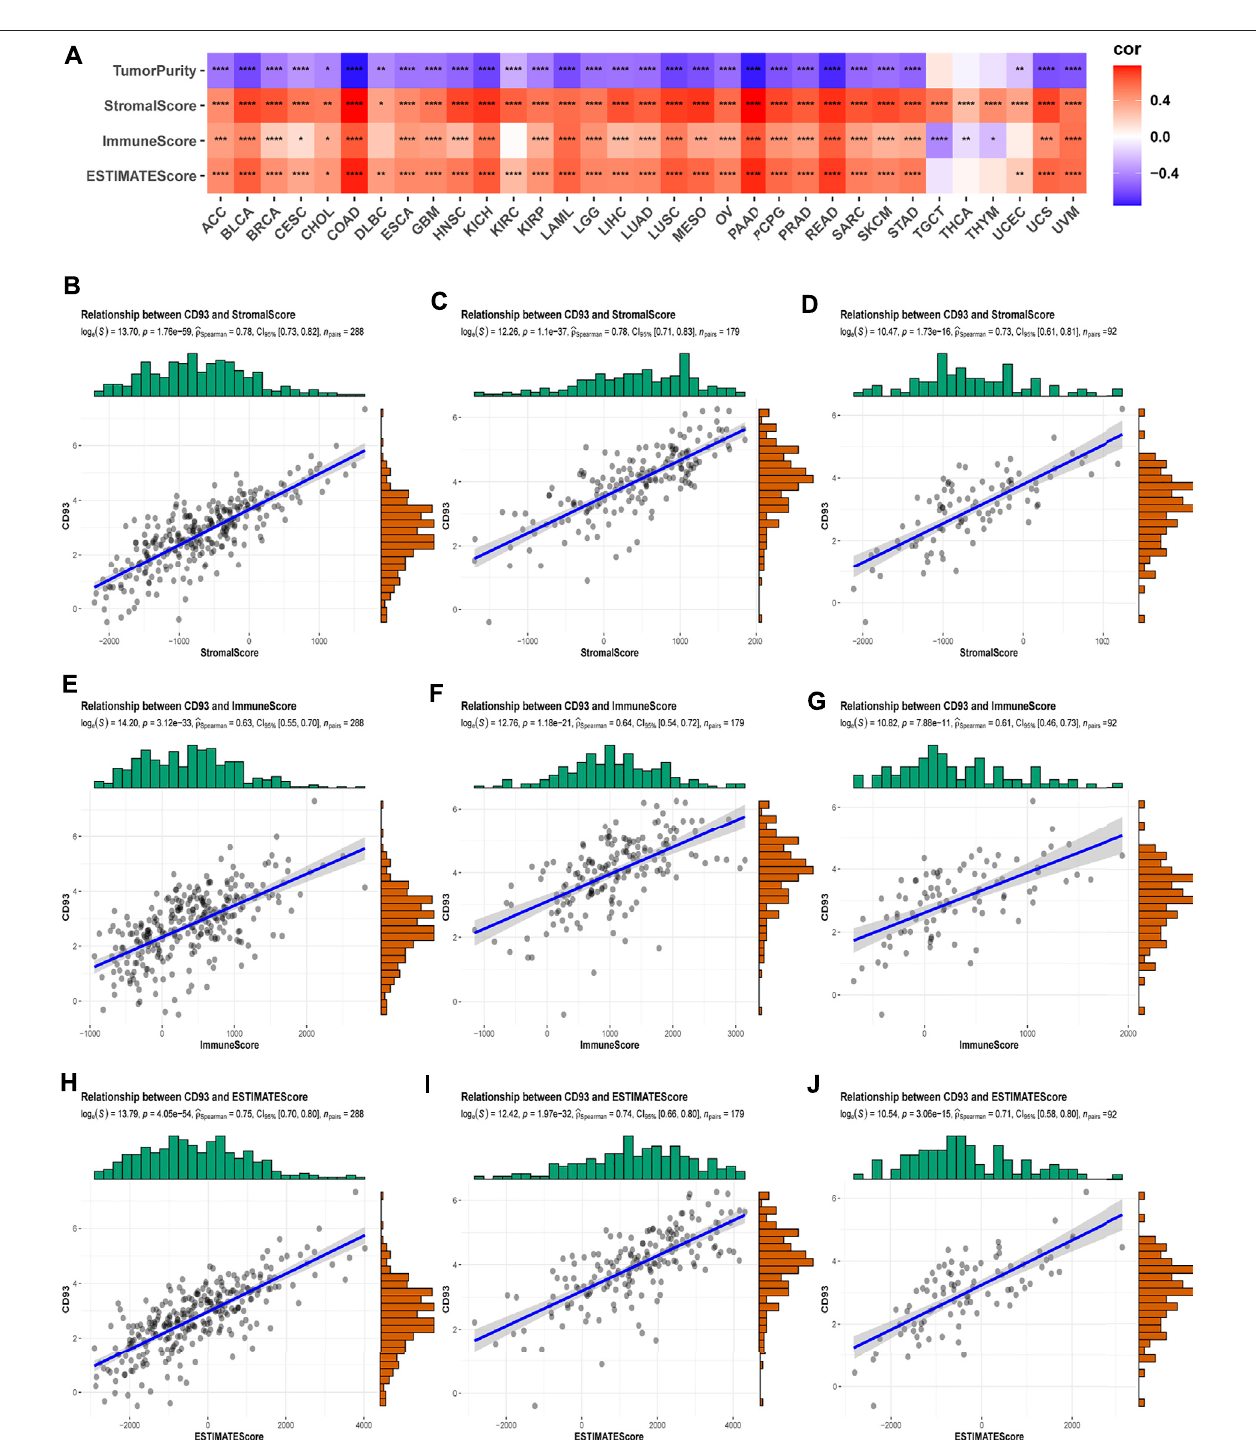
FIGURE6| Correlation ofCD93expressionwithImmuneScoreandStromalScoreinvariouscancers. (A) TheSpearman ’ scorrelationanalysisofCD93expression with ImmuneScore, StromalScores, and EstimateScores in 33 cancers (* p < 0.05, ** p < 0.01, *** p < 0.001, **** p < 0.0001). Correlation of CD93 expression with three scores in COAD (B – D) , PAAD (E – G) , and READ (H – J) .